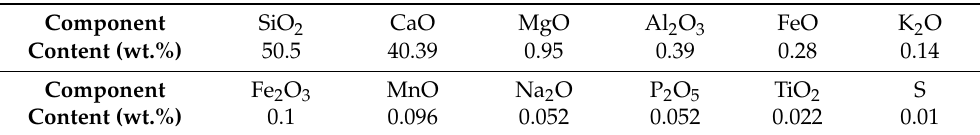
Table 3. The main chemical components contained in the wollastonite sample (reference No. GBW03123). The content values are presented in weight percentage. Component SiO 2 CaO MgO Content (wt.%)